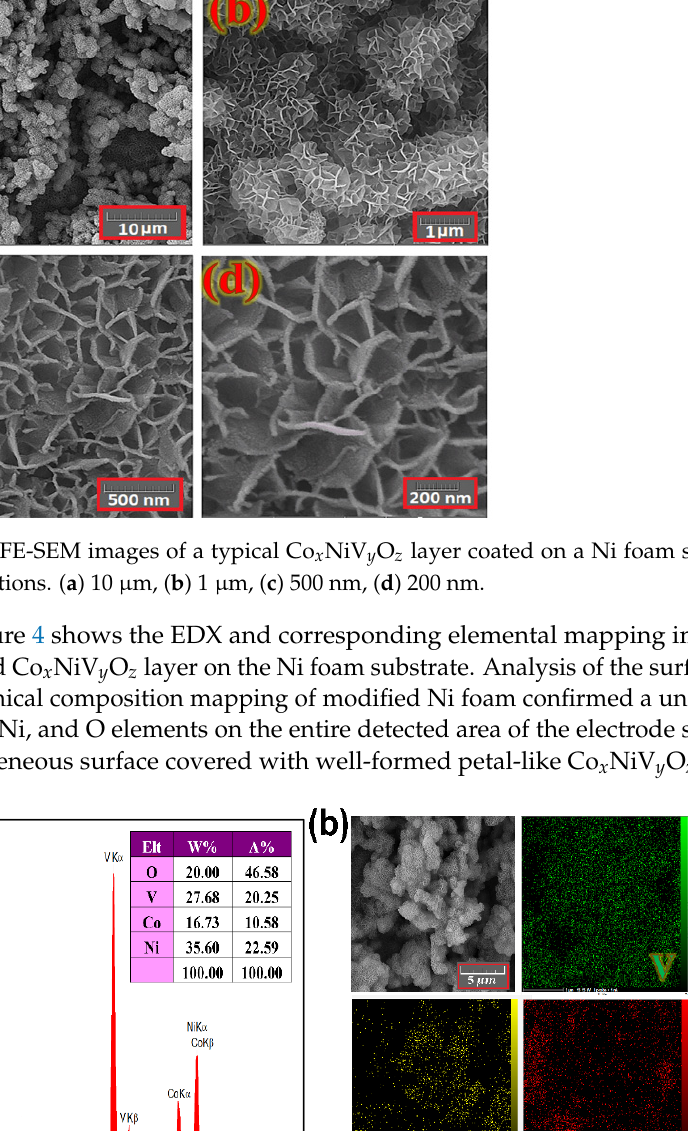
Figure 2. XPS of Ni@rGO substrate, ( a ) survey scan, ( b ) C-1 s , ( c ) Ni-2 p , and ( d ) O-1 s.